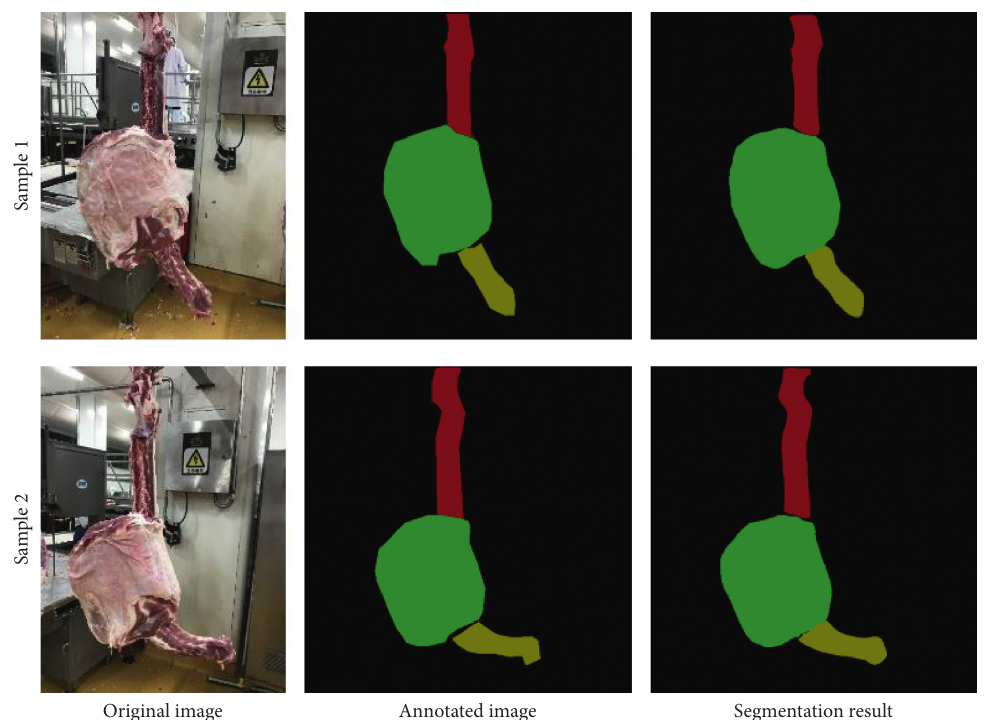
Figure 8: Examples of segmentation results on verifying